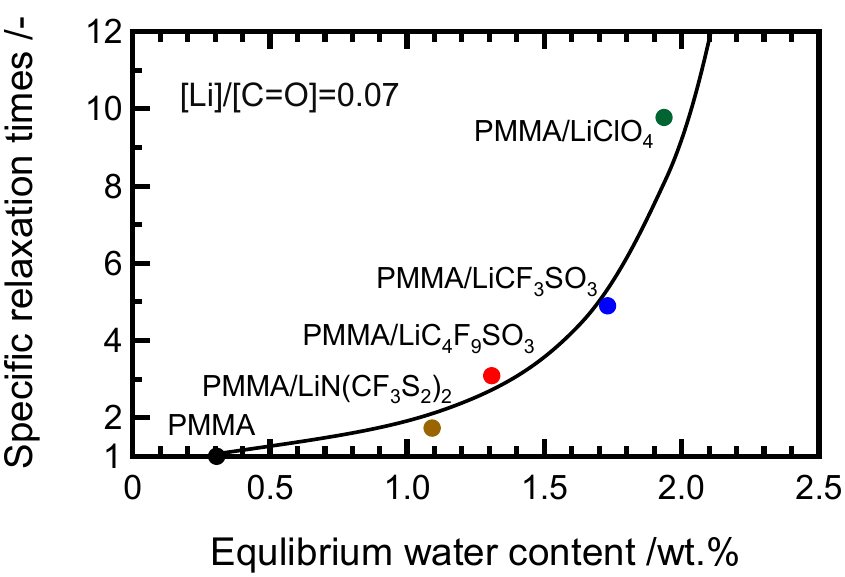
Figure 3. Equilibrium water content plotted against relative relaxation time in the terminal zone of PMMA doped with LiClO 4 (green), LiCF 3 SO 3 (blue), LiC 4 F 9 SO 3 (red), and LiN(CF 3 SO 2 ) 2 (brown) with a 0.07 molar ratio salt concentration stored at 23 °C and 70% RH. The black symbol shows the value of PMMA.